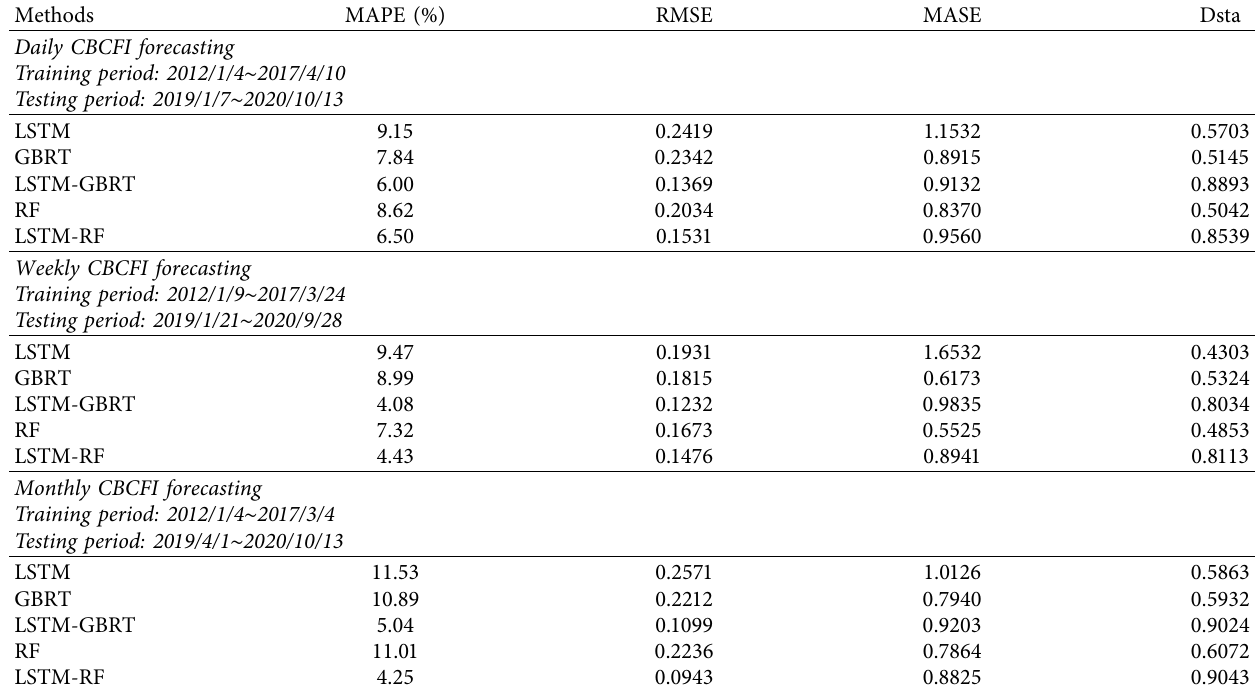
Table 5: Predictive performance of hybrid LSTM-EL and benchmark models for CBCFI prediction.